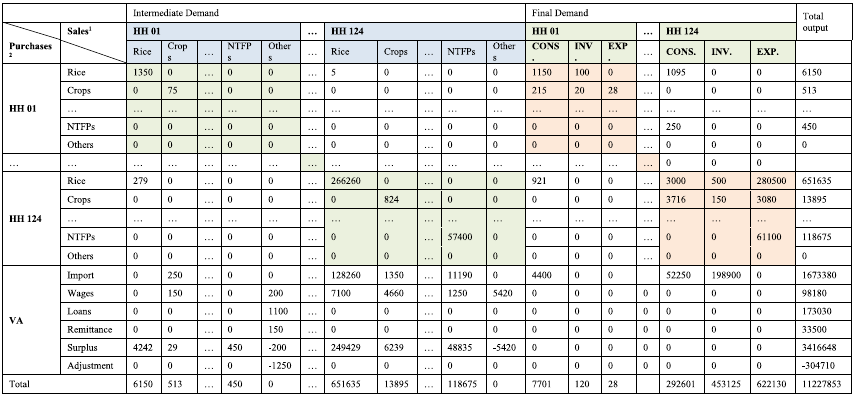
Table 10 A numerical example of VIOT for Phonxay